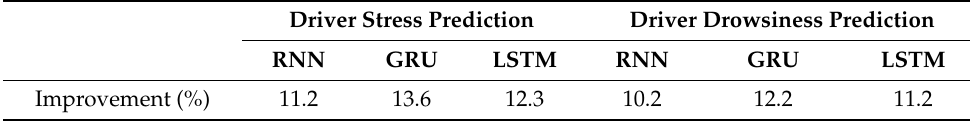
Table 4. The improvement of OA all achieved by the proposed algorithm, compared with the perfor- mance of the individual RNN, GRU, and LSTM algorithms. Driver Stress Prediction Driver Drowsiness Prediction RNN GRU